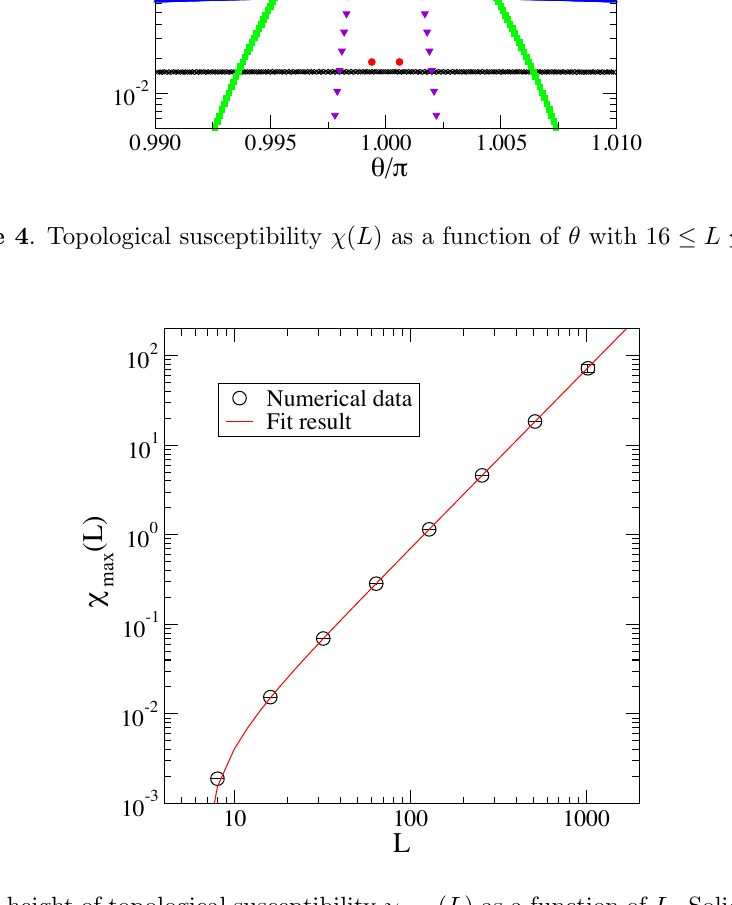
Figure 5 . Peak height of topological susceptibility (cid:31) max ( L ) as a function of L . Solid curve denotes the (cid:12)t